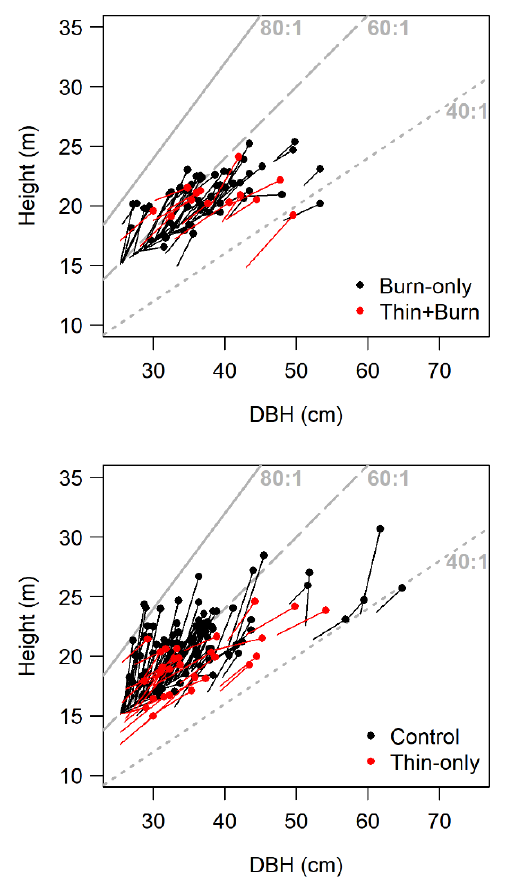
Figure 5. Douglas-fir periodic change in height and diameter relative to height-to-diameter ratio thresholds of 80:1, 60:1, and 40:1. Tree growth is represented from 2001 (segment terminus with no end cap) to 2014 (terminus with circle end cap). To better visualize the significant thinning effect, the top panel shows treatments that used prescribed fire, and the bottom panel shows treatments without prescribed fire.